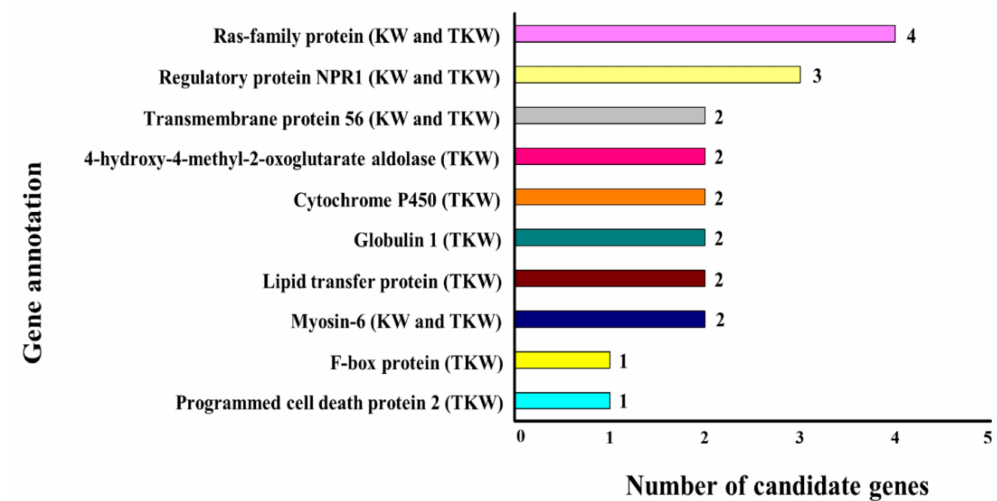
Figure 6. Functional classification of putative candidate genes controlling the kernel width and the thousand kernel weight. The number of SNPs (for either single or multiple traits) located within the genes that have the same gene annotations is shown. KW, kernel width; TKW, thousand kernel